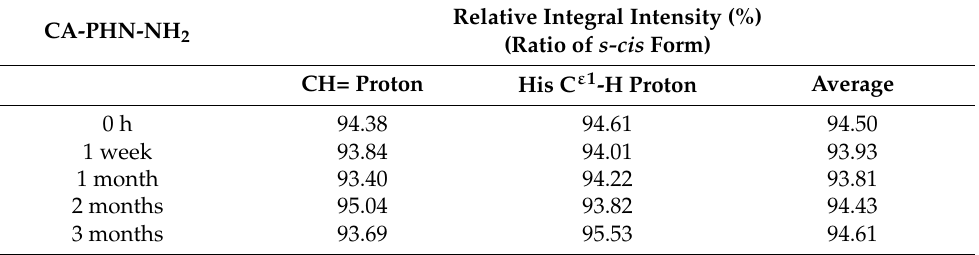
Table 3. Ratio of the s -cis form of CA-PHN-NH 2